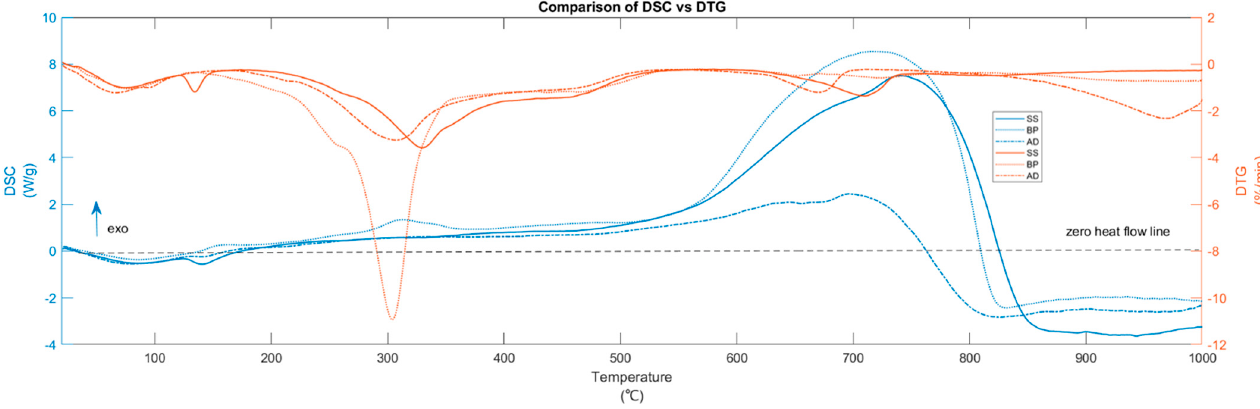
Figure 2. Comparison of DSC and DTG curves during the pyrolysis of BP, SS, and AD. In BP pyrolysis, the first stage (from 45 to 119 °C) encompasses the evaporation of moisture and the pyrolytic drying [28,29] of water molecules that are physically held by adsorption and adhesion [30]. This is also marked by the endothermic (downward-facing curve) heat flow in the DSC. Active pyrolysis initiates at 156 °C and undergoes a mass loss of 53.68 wt % until the burnout at 519 °C. Here, the shoulder peak at 256 °C and maximum peak temperature (MPT) of 303 °C is due to hemicellulose and cellulose degradation, re- spectively. Although active pyrolysis usually starts around 200 °C [16], reactions between 150 and 200 °C can include the hydrolysis of extractives [16] and softening of hemicellu- lose [31]. There is a small exotherm at 150 °C. During active pyrolysis, cellulose devolati- lization is endothermic or exothermic (depending on its kinetic route [32,33]), while that of hemicellulose and lignin is exothermic [34]. Pure hemicellulose pyrolysis results in two peaks at around 245 and 295 °C [35]. The first peak arises from the breaking of the branched structures and glycosidic bonds, while the second is from the fragmentation of the ring units [36]. These peaks shift to lower temperatures in the presence of AAEM and merge with those from cellulose. The literature [35,37] shows that from 350 °C to burnout, the broad shoulder peak in DTG arises from the lignin’s ([C 10 H 12 O 3 ] n ) overlapping steady decomposition. This is further confirmed from the exothermic DSC and the featureless D- DSC (seen later in Section 3.3). Lignin can exist as H type (p-hydroxyphenyl C 9 H 12 O 2 ), G type (guaiacyl C 10 H 12 O 3 ), and/or S type (syringyl C 11 H 14 O 4 ) [38]. Depending on its form, lignin can have a wide degradation range from 200 to 800 ◦ C and lacks precise burnout points. Net exothermic DSC during active pyrolysis signifies the influence of hemicellulose and lignin transformation [39] and the favorability of the kinetic route for exothermal